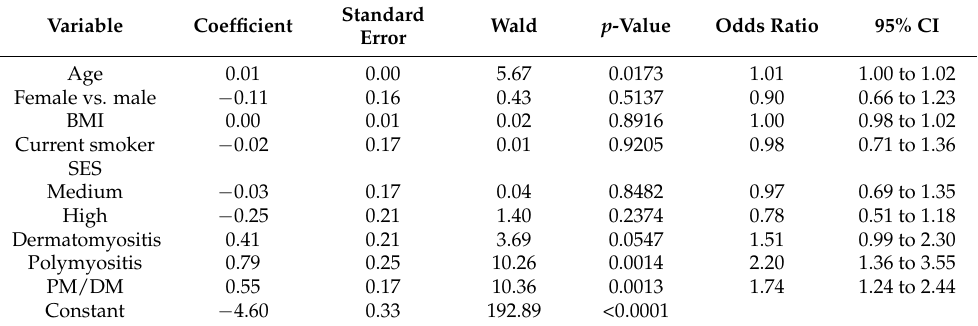
Table 2. Multivariable logistic regression analysis investigating co-variates associated with epilepsy.